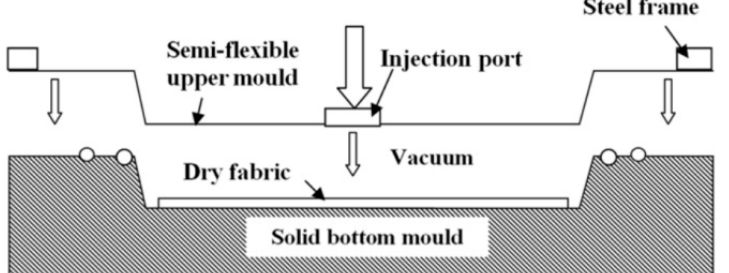
Figure 26. Schematic diagram of light resin transfer moulding (reproduced with permission from [312]; copyright© 2021 Elsevier Ltd.).